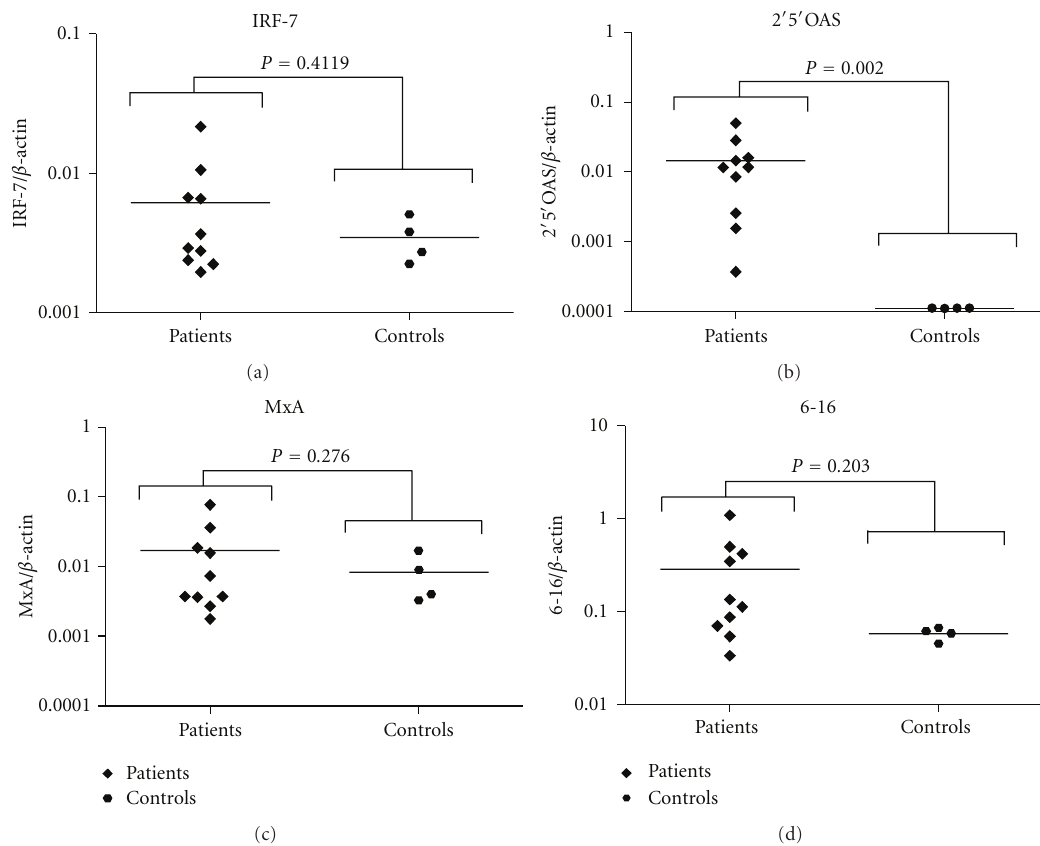
Figure 2: Basal levels of IRF-7 and ISGs in PBMCs from healthy donors and SSc patients. PBMCs from healthy donors and SSc patients were purified, and total RNA extraction was performed. The RNA obtained was used as template in reverse transcription reactions, and the resulting cDNA was used in real-time PCRs to measure IRF-7 (a), 2 (cid:2) 5 (cid:2) OAS (b), 6–16 (c), and MxA (d)